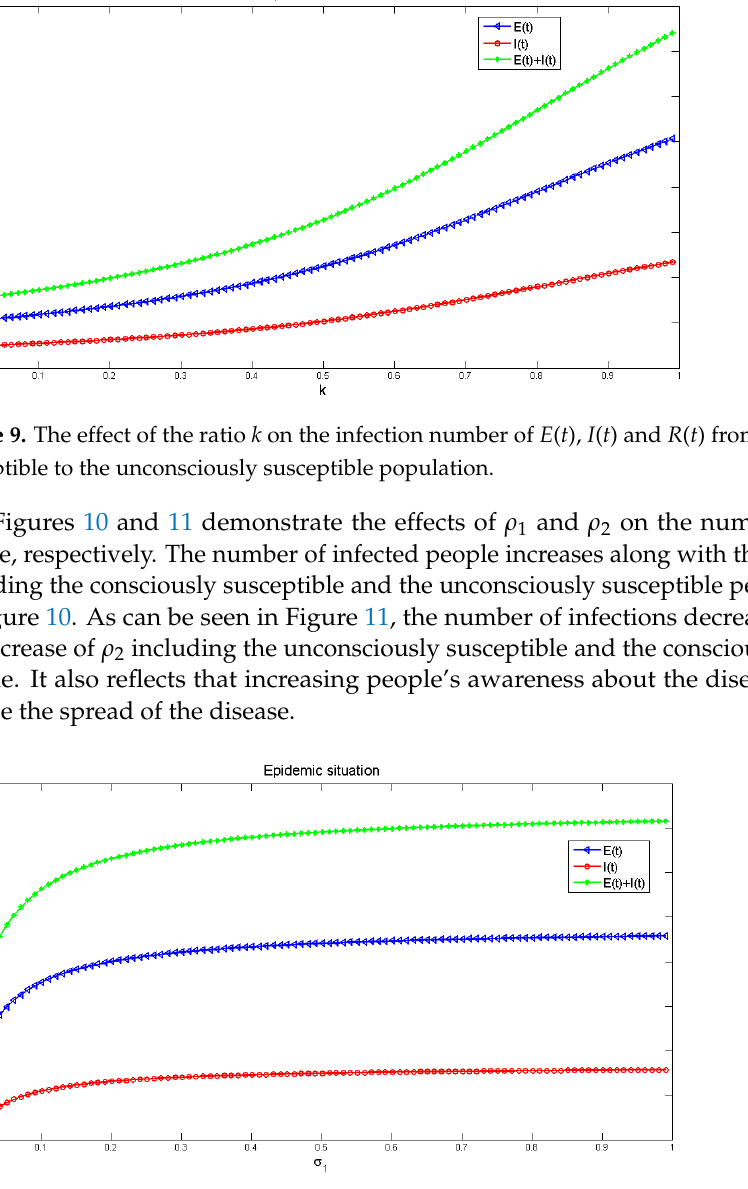
Figure 10. The influence of probability ρ 1 from conscious susceptible to unconscious susceptible on the number of infected people.